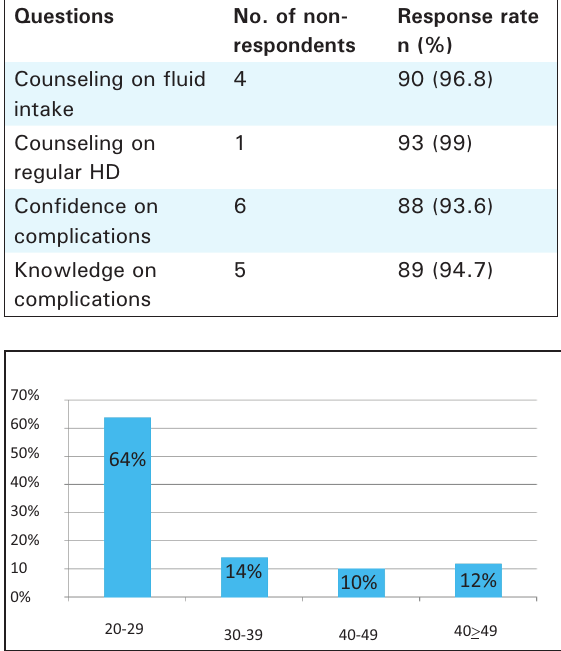
Figure 1. '6$*-($70-$"%'".'()*+"%3)%-*',88"(3$%&'-"' the age group (n=93).